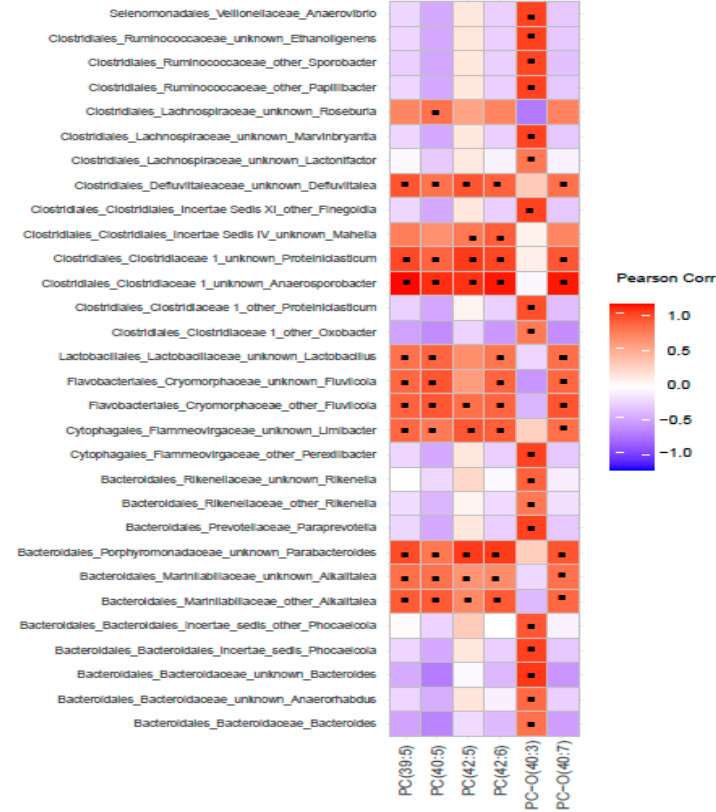
Figure 4. Correlation between the composition of bacteria in the fecal microbiome and alkyl-acyl- glycerol phosphocholines in the hippocampus of pigs fed six servings of WBM. Pearson Correlation coefficients were estimated for each pairwise comparison of bacterial taxa and metabolites within the species of alkyl-acyl-glycerol phosphocholine lipids. Black dots within heatmap represent significant relationships ( p -value < 0.05).